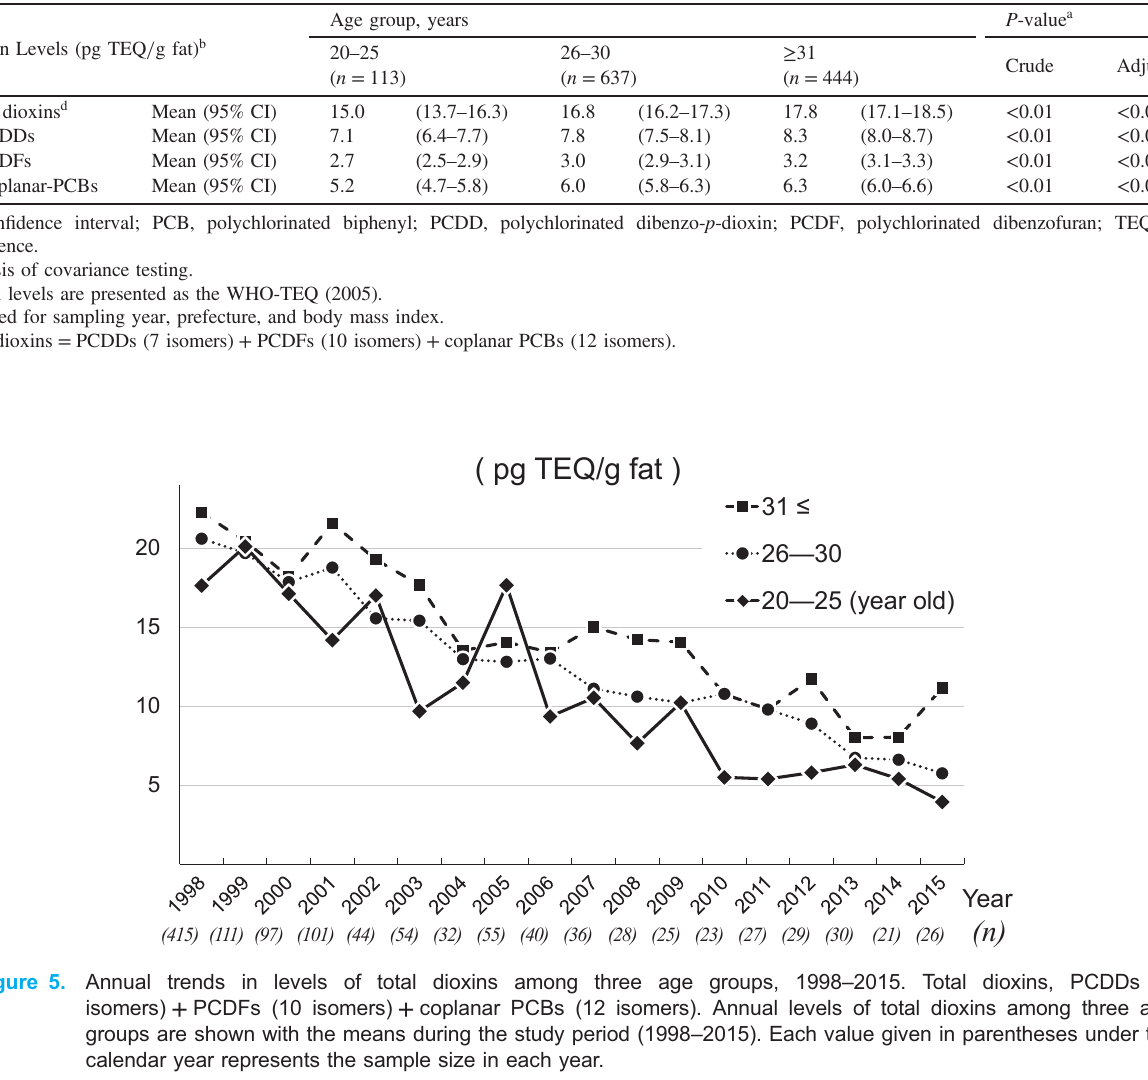
Table 3. Dioxin levels among three age groups ( n = 1,194)